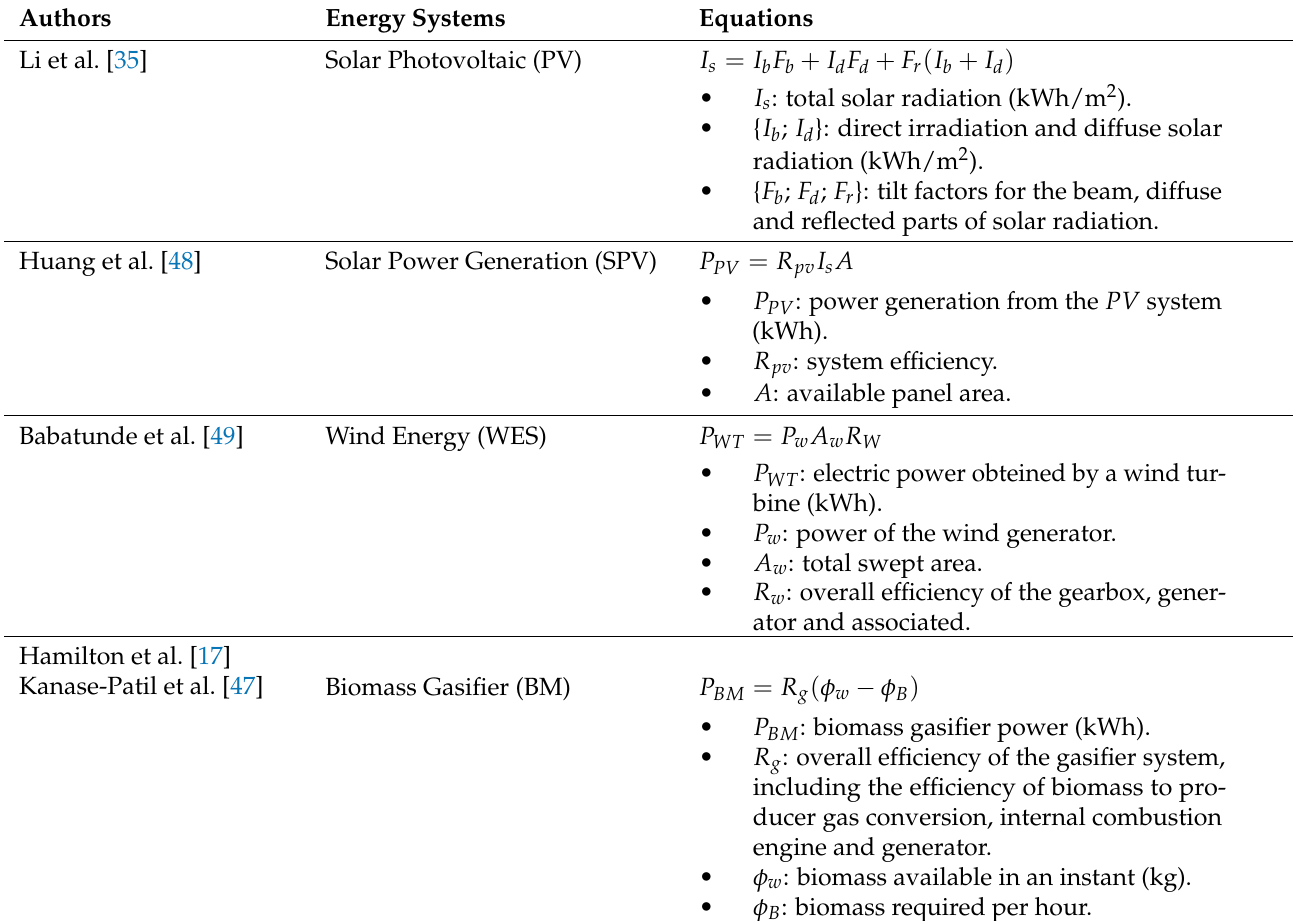
Table 1. Description of each of the submodel expressions for the electrical